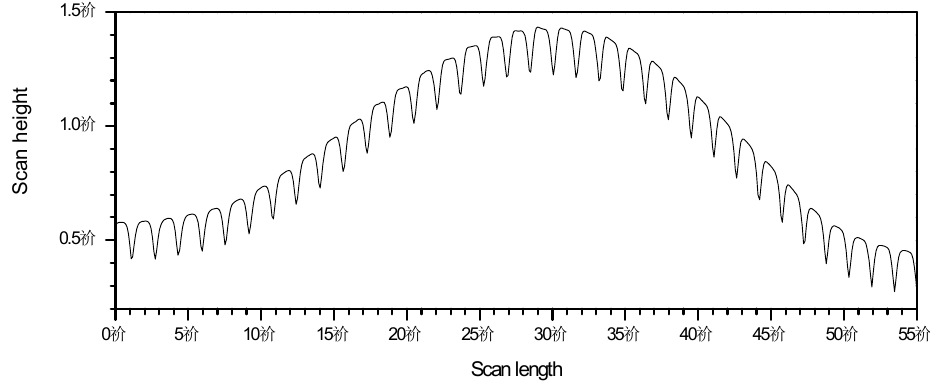
Figure 7. Line scan of the hierarchical structures master shown in Figures 5 and 6 above. The height of both types of structures is well preserved from the individual masters to the hierarchical structure.